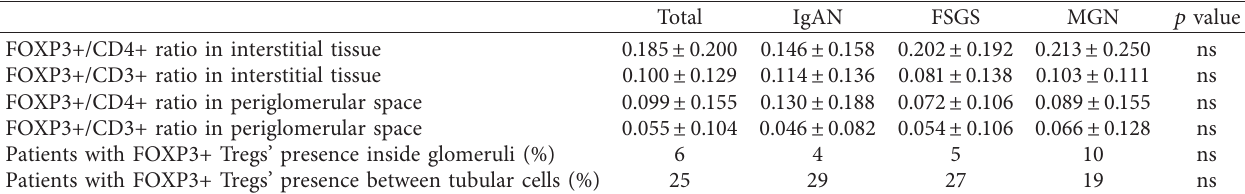
Table 3: FOXP3+/CD4+ and FOXP3+/CD3+ ratios in the interstitial tissue and periglomerular space and qualitative assessment of FOXP3+ Tregs’ presence inside glomeruli and between tubular cells.